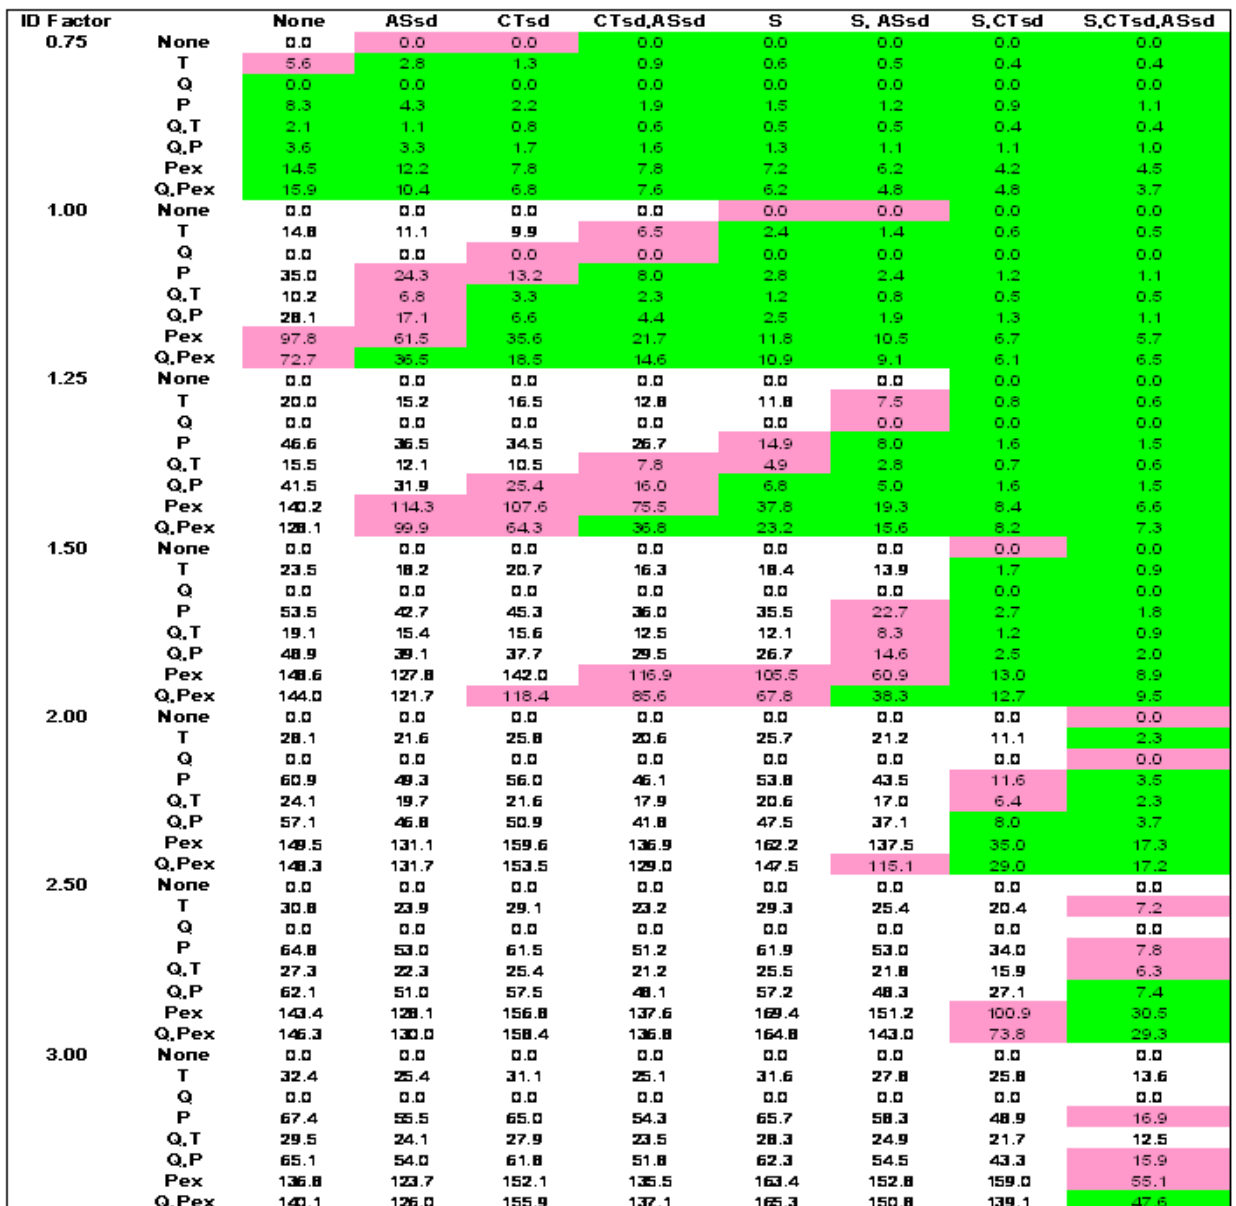
Figure 3. Population antiviral coverage. S=schools closed; CTsd=child/teenager social distancing; ASsd=adult/senior socials distancing; Q=household quarantine; T=antiviral treatment; P=antiviral prophylaxis of household members; PEx=extended antiviral prophylaxis. For Ferguson-like disease manifestation and implementation threshold when 10 cases are diagnosed. Case-based interventions are applied directly to or around diagnosed individuals to limit transmission and are: Q, T, P, and PEx. Network-based interventions are applied to affect links and contacts between individuals throughout the entire network and are: S, CTsd, ASsd (where adults continue to attend work, although at a 50% reduction in contacts at the workplace). Case-based interventions vertical; network-based interventions horizontal. Green shading denotes infection rates # 10 percent of population. Pink shading denotes infection rates between 10 and 25 percent.